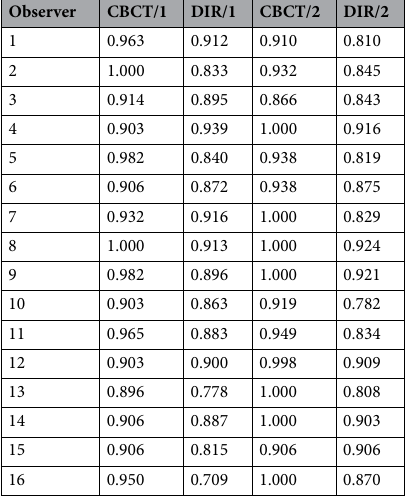
Table 2. Individual AUC (area under the curve) values of the 16 observers for the first (1) and second (2) trials of the digital volume tomography (CBCT) and intraoral images (DIR) image acquisition methods.